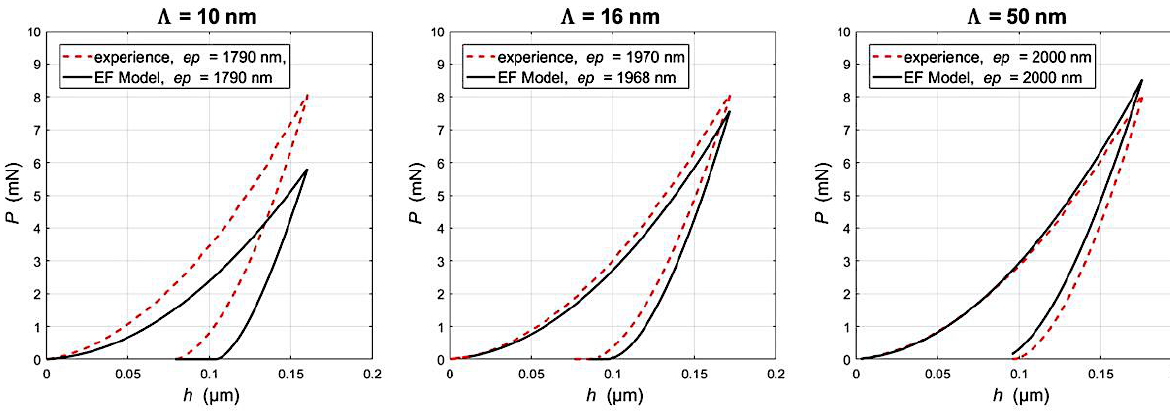
Figure 4. Comparison of the (P-h) experimental and simulated curves for Λ = 10, 16 and 50 nm with a perfect interface between TiAl and TiAlN